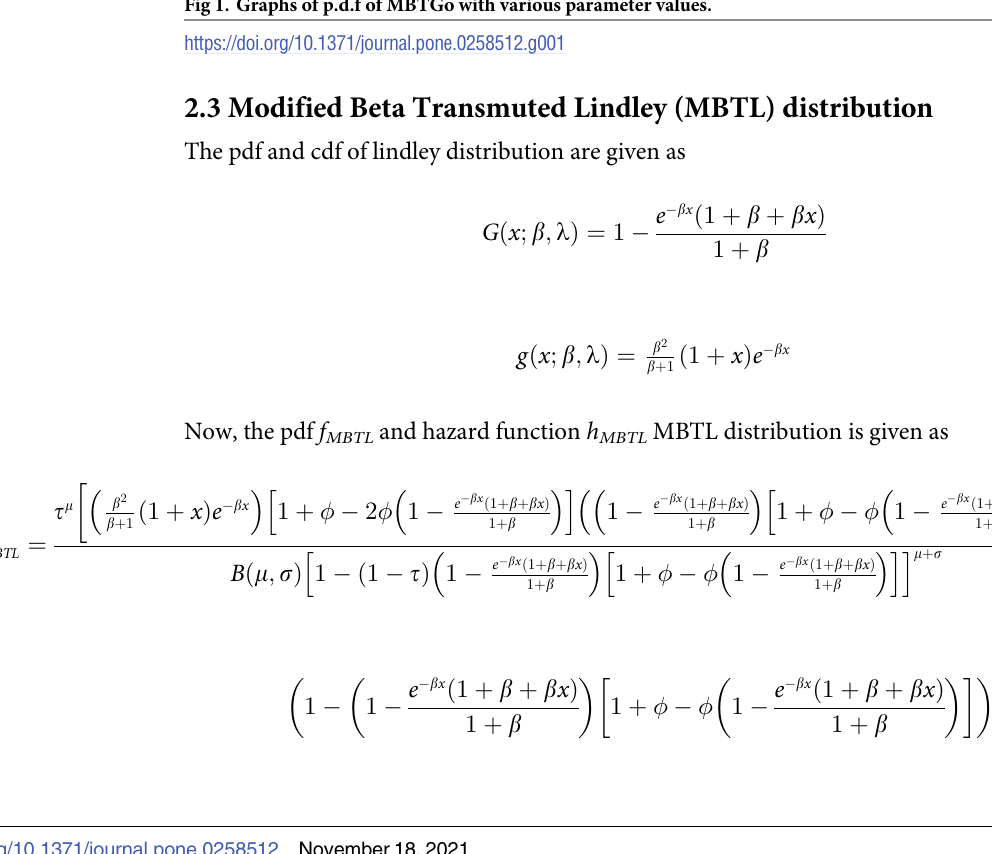
Fig 1. Graphs of p.d.f of MBTGo with various parameter